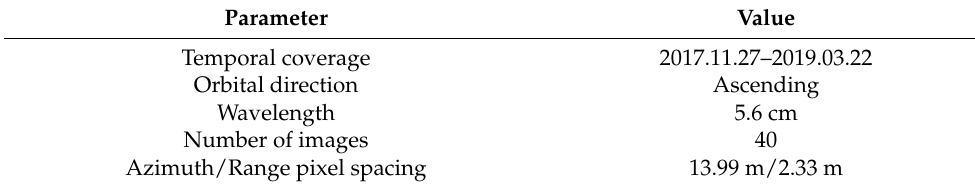
Figure 1. ( a ) Basic information and location of study area; ( b ) The terrain and altitude of study area. Table 1. Main parameters of the Sentinel-1 data used in this